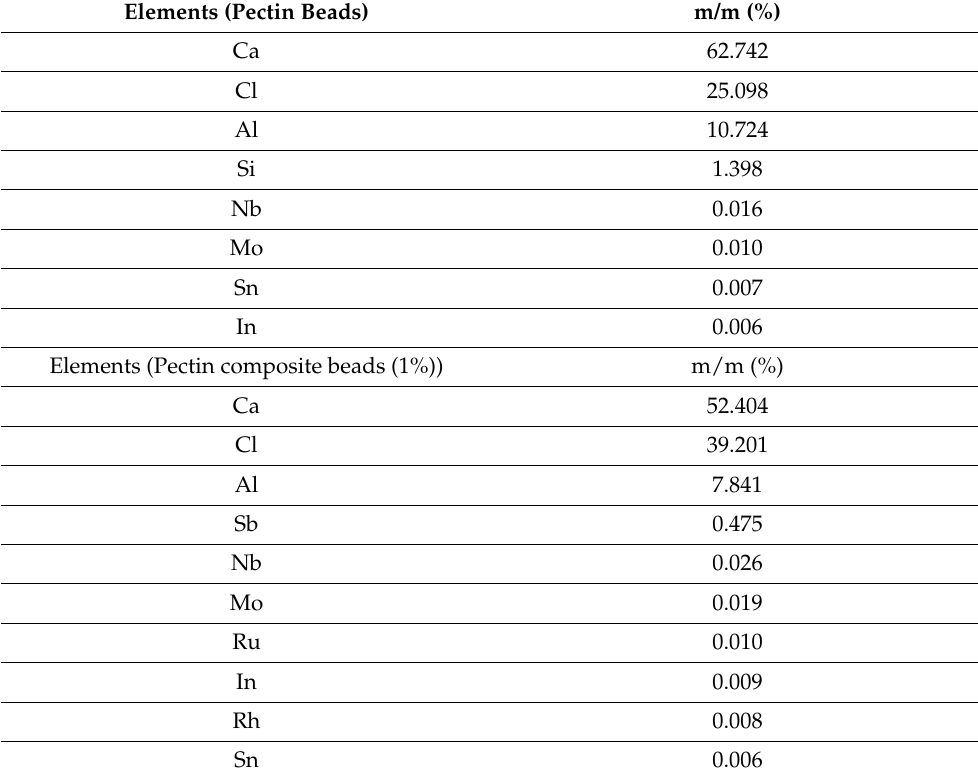
Table 1. Relative abundance of elements presented in pectin beads and pectin composite beads